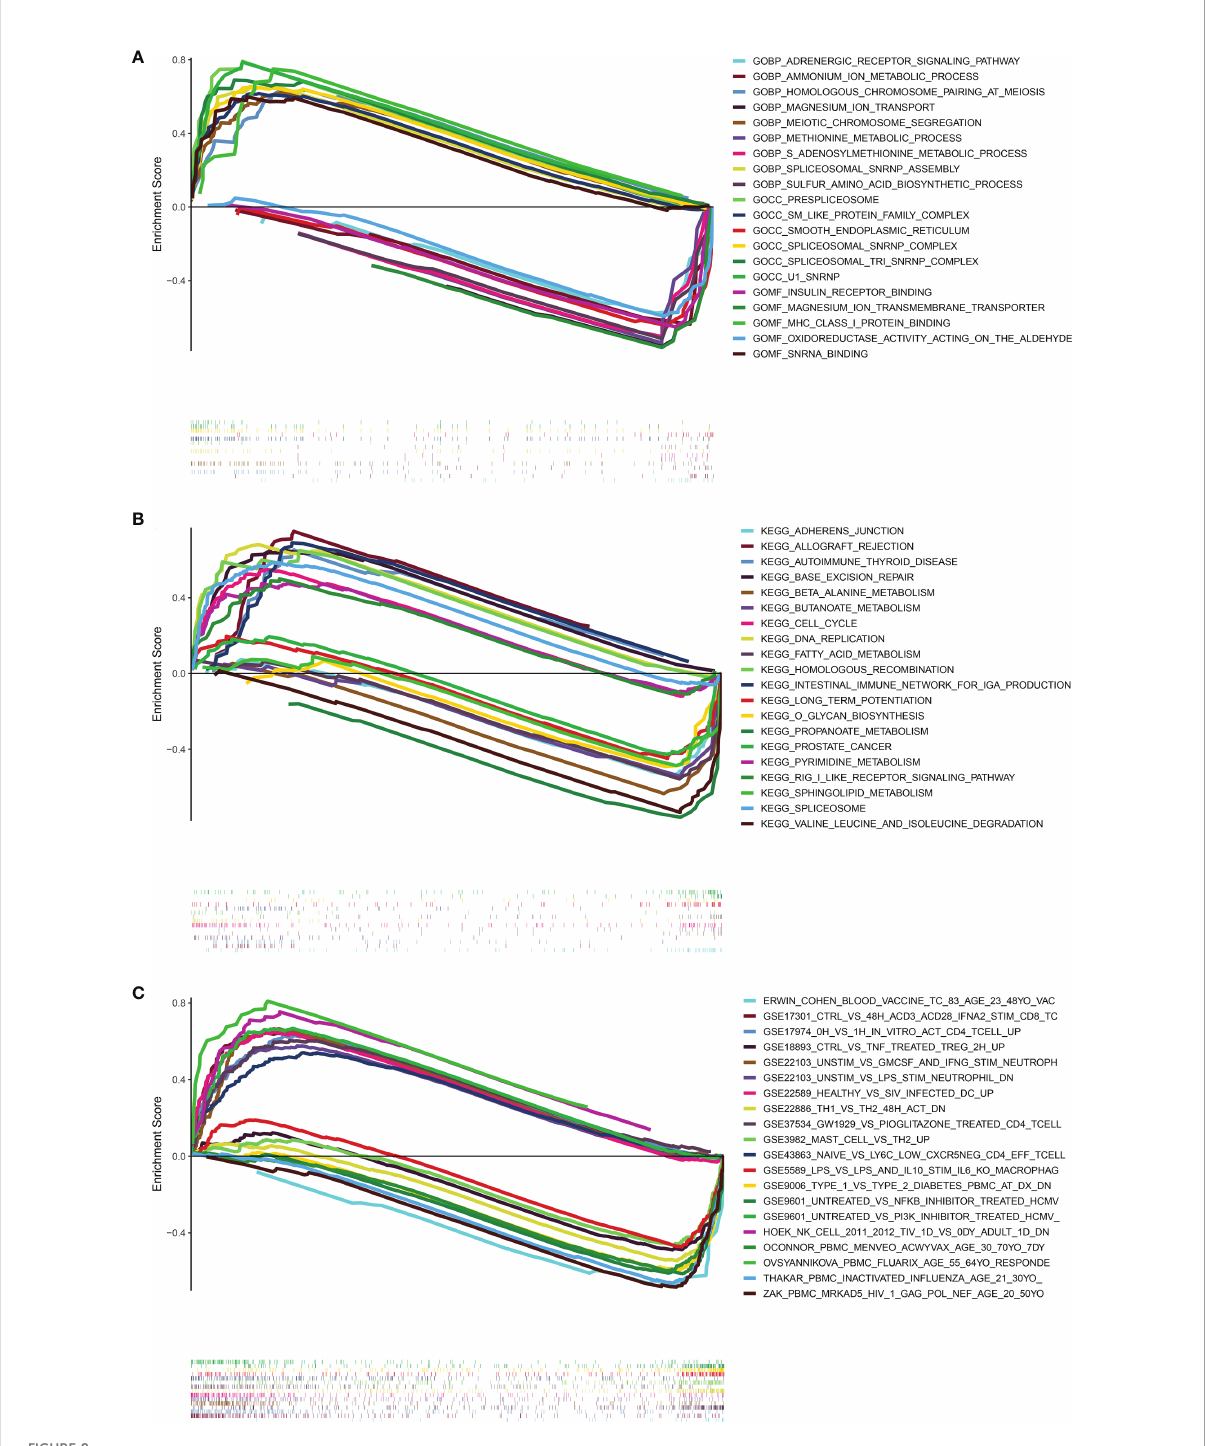
FIGURE 8 Results of GESA in TCGA. (A) The results of GSEA in GO (BP, CC, MF). (B) The results of GSEA in KEGG. (C) The results of GSEA in immunologic signature gene sets. (curves above horizontal line: positive correlation; the curve below horizontal line: negative correlation; the heatmap below curves: the enrichment degree of these pathways or gene sets in PRAD